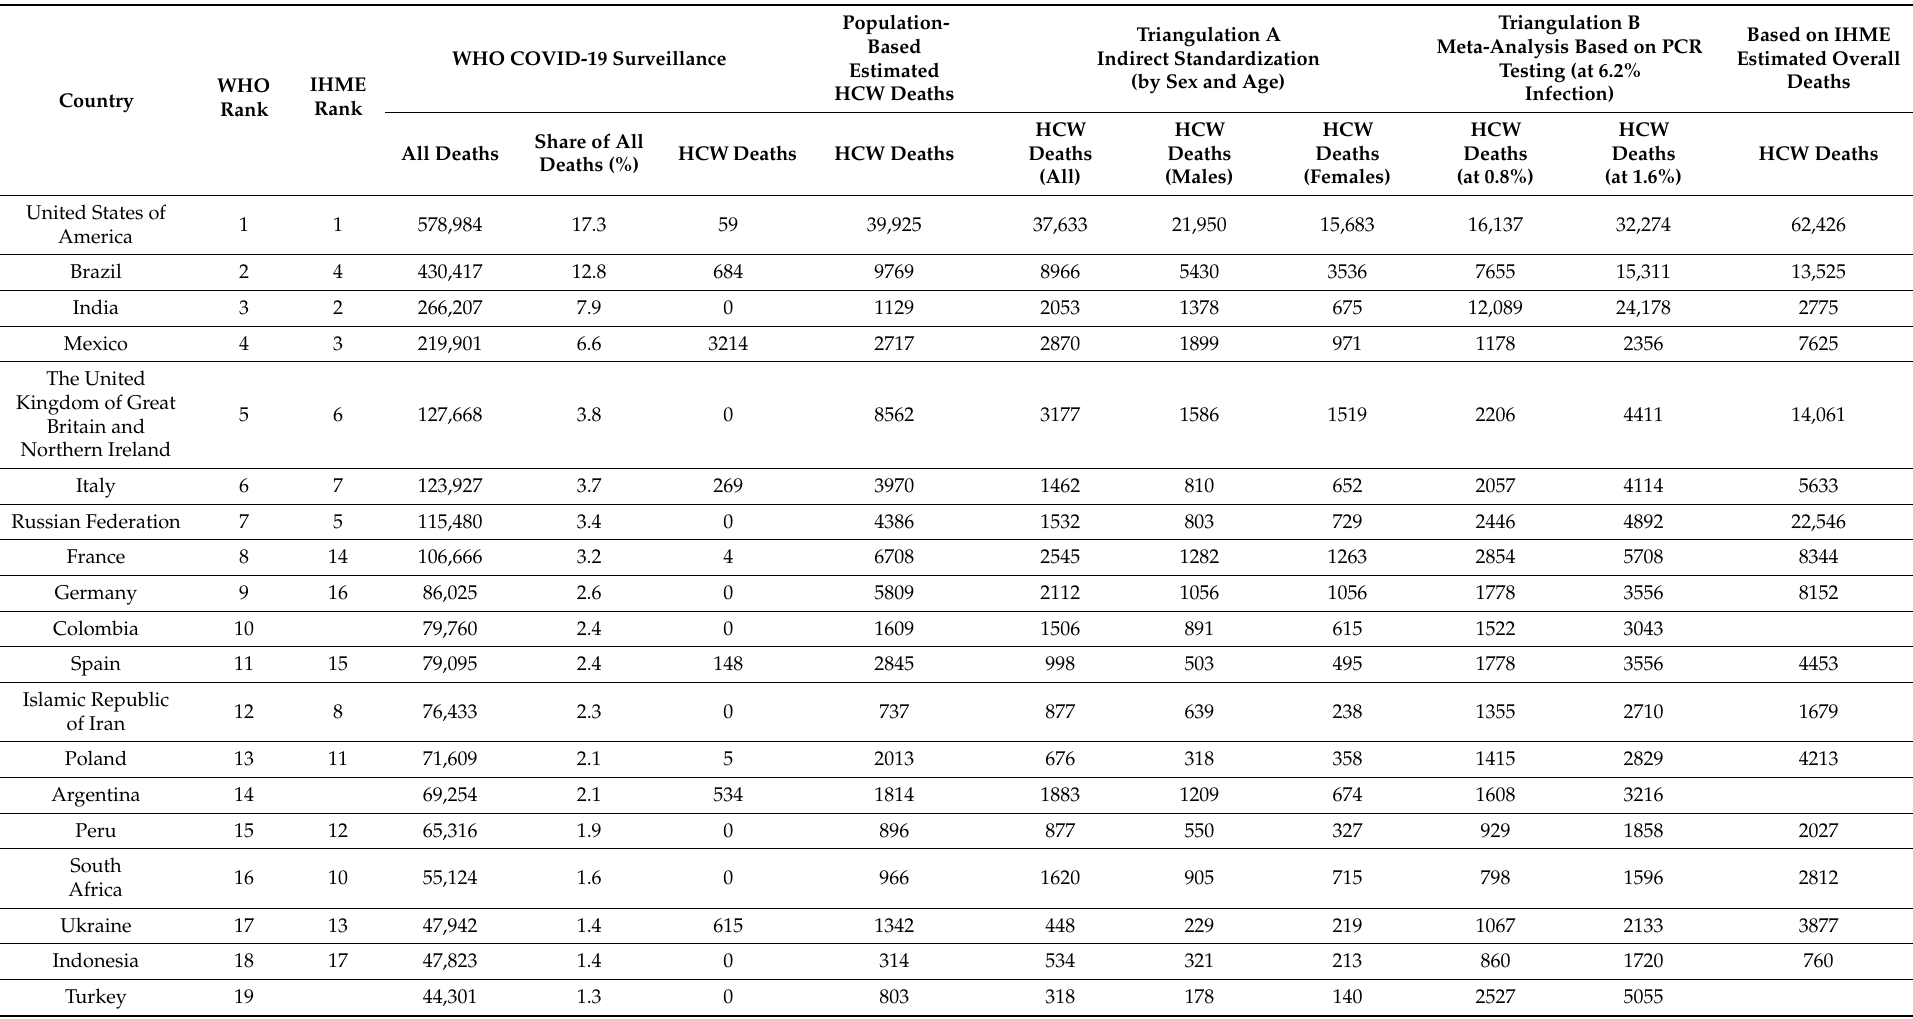
Table 1. Comparison of the population-based deaths in HCWs related to COVID-19 using surveillance data reported to WHO and IHME’s total deaths—top-ranking countries with Polymerase Chain Reaction (PCR Test) (January 2020–May 2021)